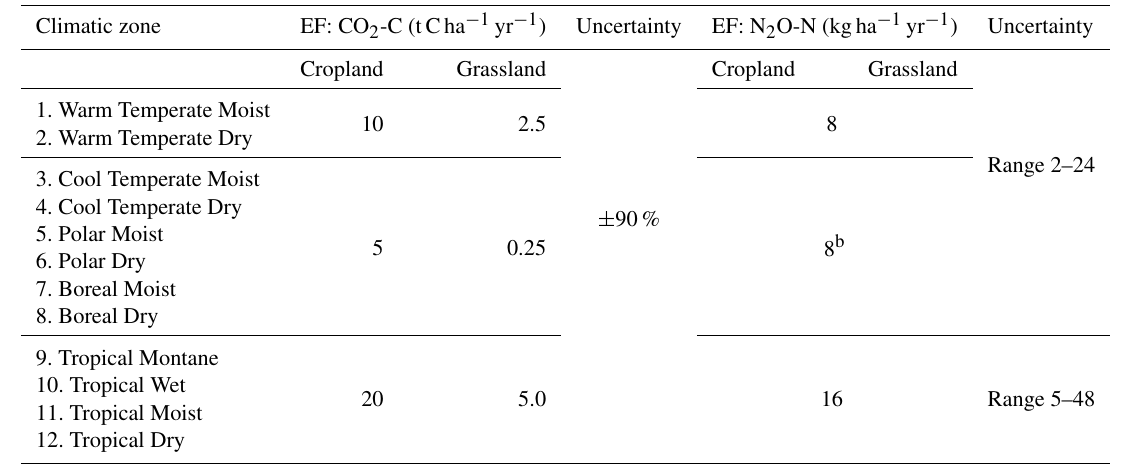
Figure 4. Climatic zones based on IPCC classification (JRC, 2010). Table 3. IPCC default emission factors assigned by gas and climatic zone a .